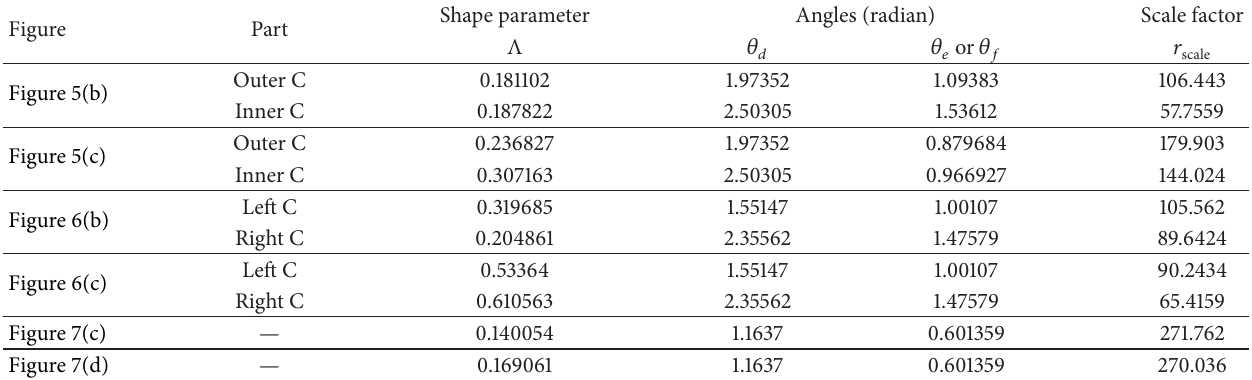
Table 2: The value of parameters obtained in LAC algorithm for C-shaped gap.